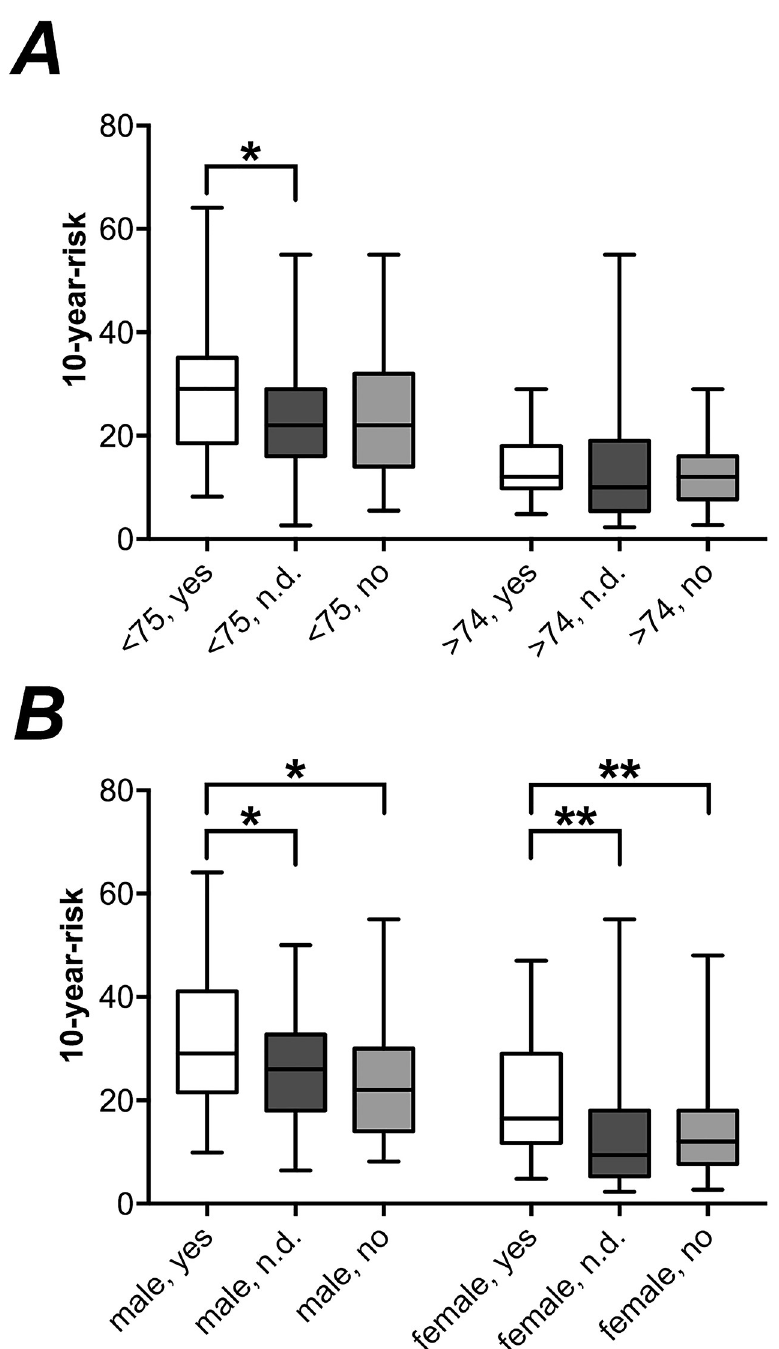
Fig 4. 10-year probability (mean, min-to-max and standard deviation) based on the FRAX-tool in all patients, with positive (yes) and negative (no) result in DXA and no BMD measurement using DXA (n.d.) divided by (A) sex and (B) age (below 75 and above 74